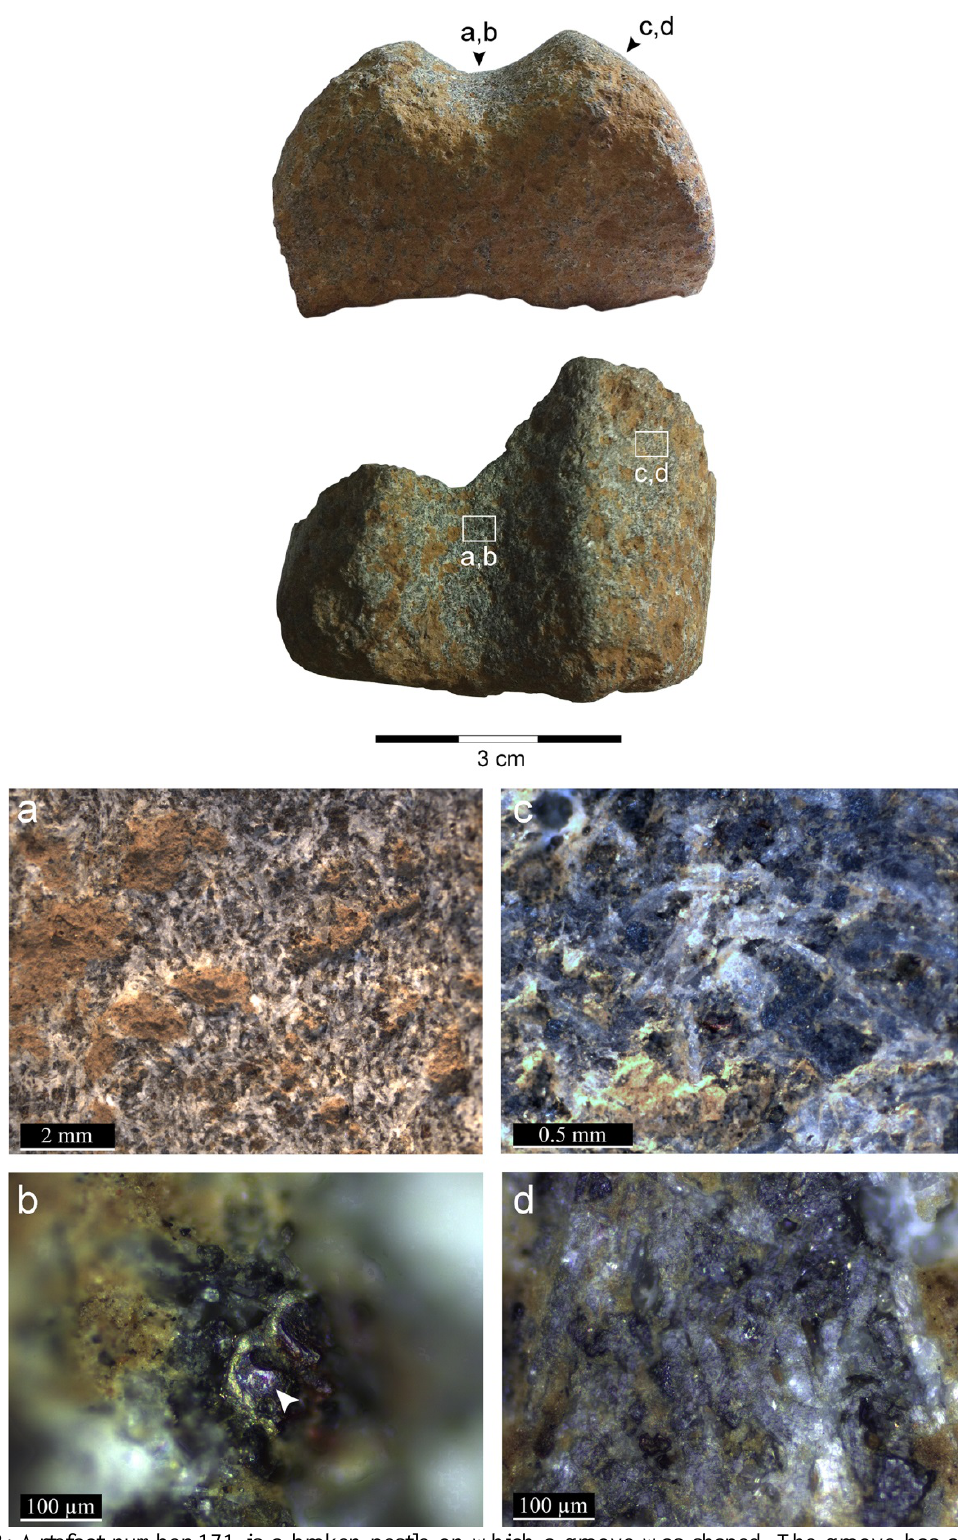
Figure 3: Artefact number 171 is a broken pestle on which a groove was shaped. The groove has a concave bottom and walls extending outward. Locations of micrographs are indicated by arrows. Traces inside the groove interpreted as having been produced by contact with medium hardness material such as bone or wood: a) flat peaks with flattening extending into the lower surfaces (x6.7), b) micro-polish developed on protruding surface indicated by the white arrow (x200). Traces on the perimeters interpreted to be produced by contact with a hard stone: c) extremely flat peaks with sharp edges and few remnants of lower areas (x50), d) thin and transparent polish spreading on the wide surface of the basalt